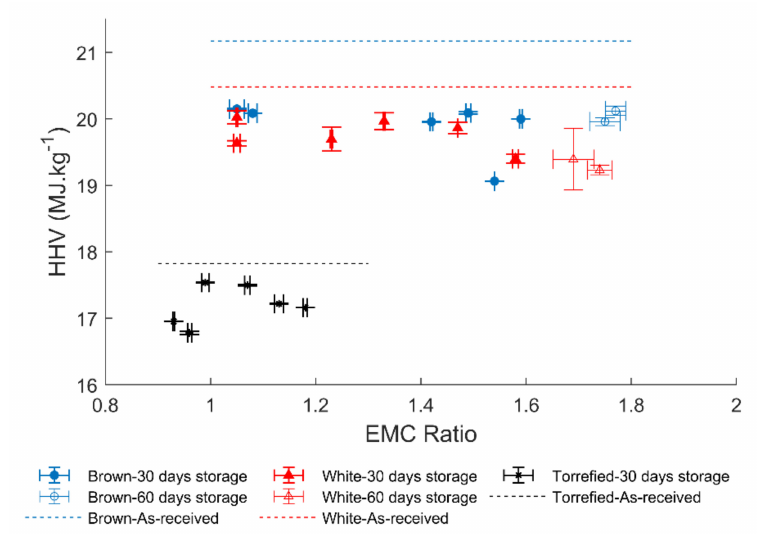
Figure 4. HHV versus EMC of pellets after 30 and 60 days of storage at di ff erent storage